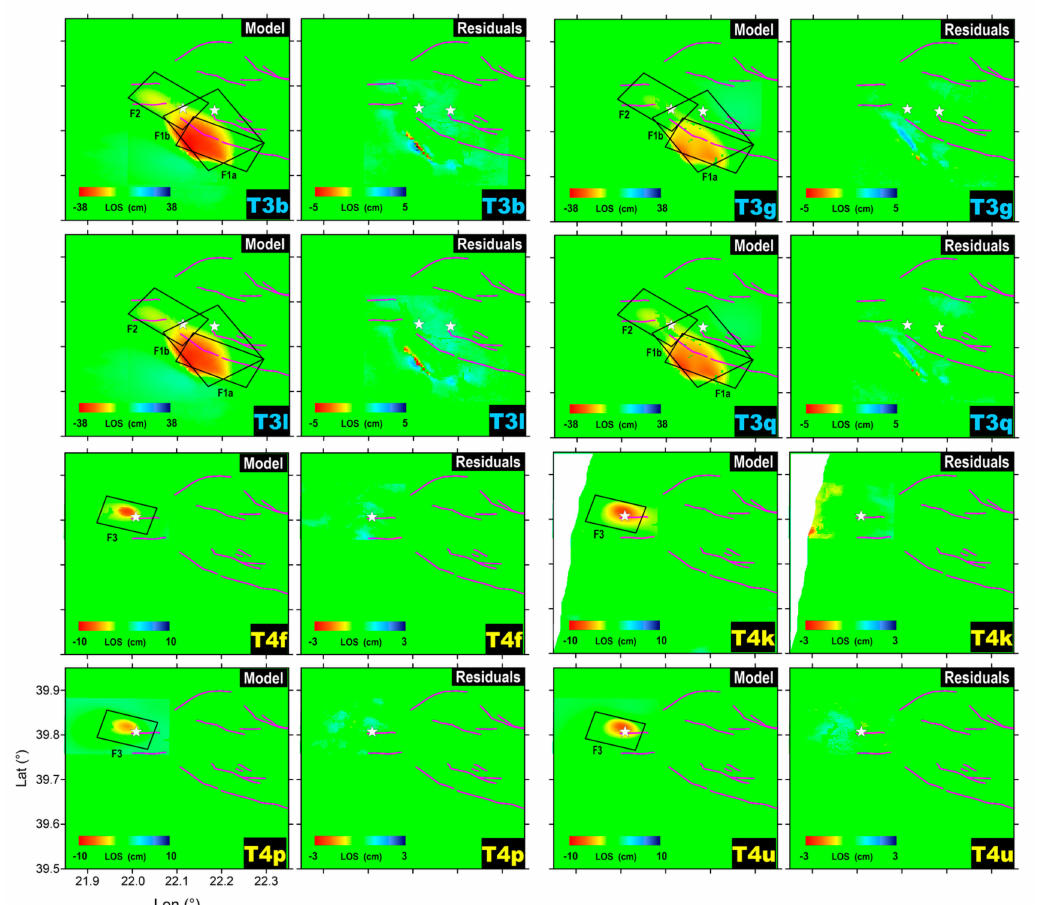
Figure 4. Line-of-sight projected displacement maps computed from the distributed slip modeling (T3 and T4 timeframes) and corresponding residual maps for the S1 interferograms shown in Figure 3. Fault lineaments and the retrieved plain faults are indicated by magenta and black lines, respectively; white stars indicate the epicenters of the three largest events. All the uniform slip modeling results are presented in the Supplementary Materials as Figures